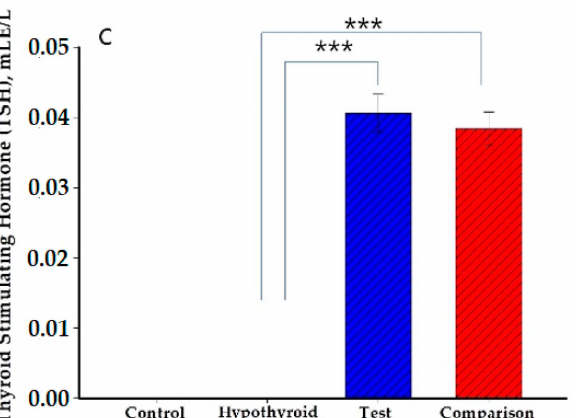
Figure 4. Results of Thyroid Stimulating Activity: ( a ) triiodothyronine (T3), ( b ) thyroxine (T4), ( c ) Thyroid-stimulating Hormone (TSH). Control, hypothyroid, test and comparison groups were given deionized water, methimazole, iodine/ β -CD and potassium iodide, respectively (mean values ± SD). *** p <